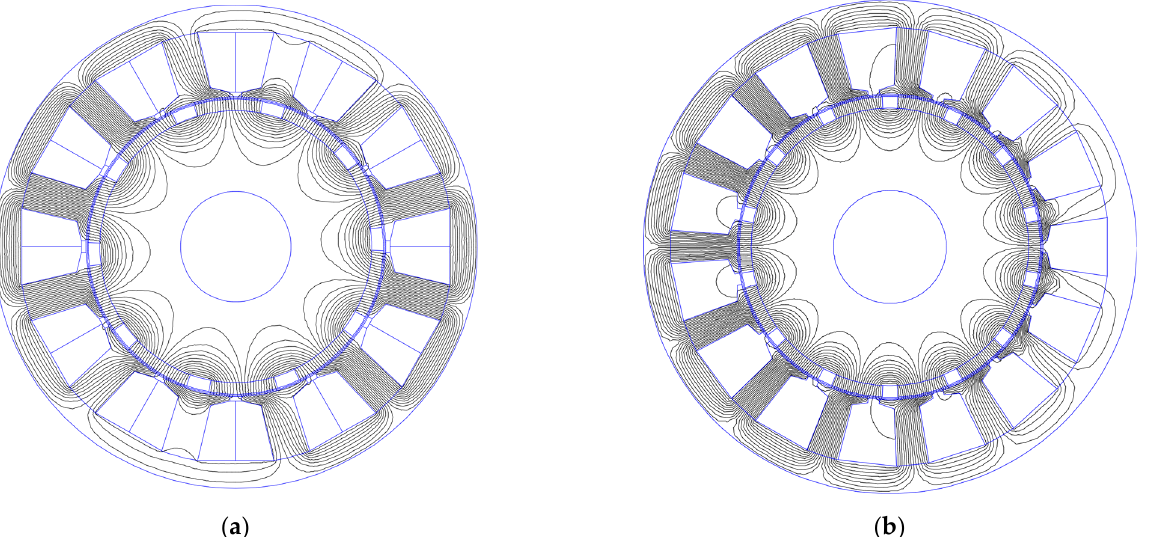
Figure 7. Drive motor with concentrated winding: ( a ) 2p = 10, and Q s = 12 and ( b ) 2p = 14, and Q s = 15—unbalanced.